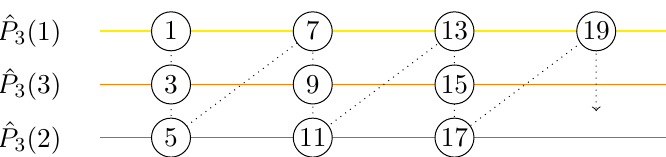
Figure 5 . Periodicity of the function P α ( n ) for α = 3 , with odd argument n ∈ 2 N 0 + 1 . Each circle contains increasing odd integers n = 2 l +1 , while the horizontal lines represent the associated term P ( n ) . The periodicity P ( n ) = P ( n mod 3) permits to group all odd numbers n in α = 3 3 3 3 different groups. All different values of ˆ P ( k ) can be populated by P ( n ) for odd values of α . Even α α arguments n ∈ 2 N behave in the same way for odd values of α . 0